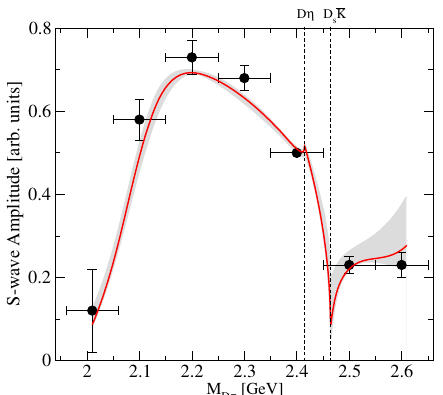
Figure 7. Comparison of the S-wave amplitude determined from the calculation of [39] with the S-wave anchor points from the experimental analysis, shown as the data points [42]. The red (solid) line gives the best fit results and the grey band quanti- fies the uncertainties. The dashed perpendicular lines indicate the location of the D η and D s ¯ K threshold, respectively. Figure from (2400) 0 and 0